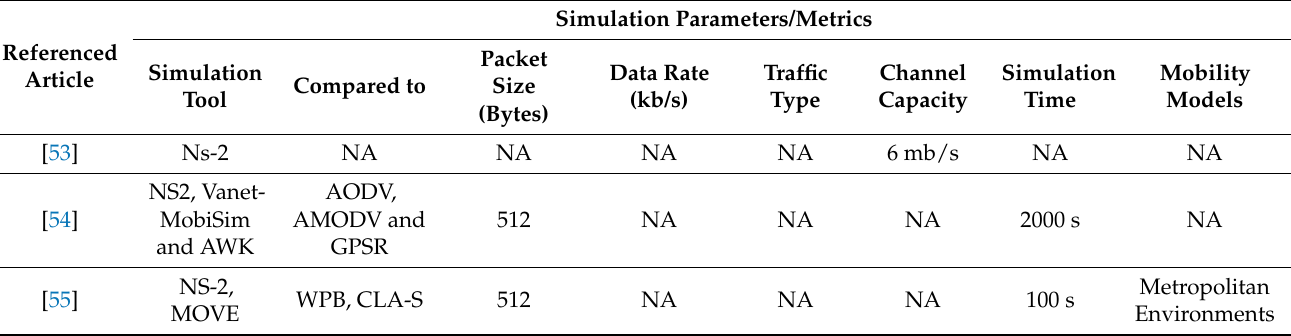
Table 15. Routing parameters of urban scenario with streets based routing